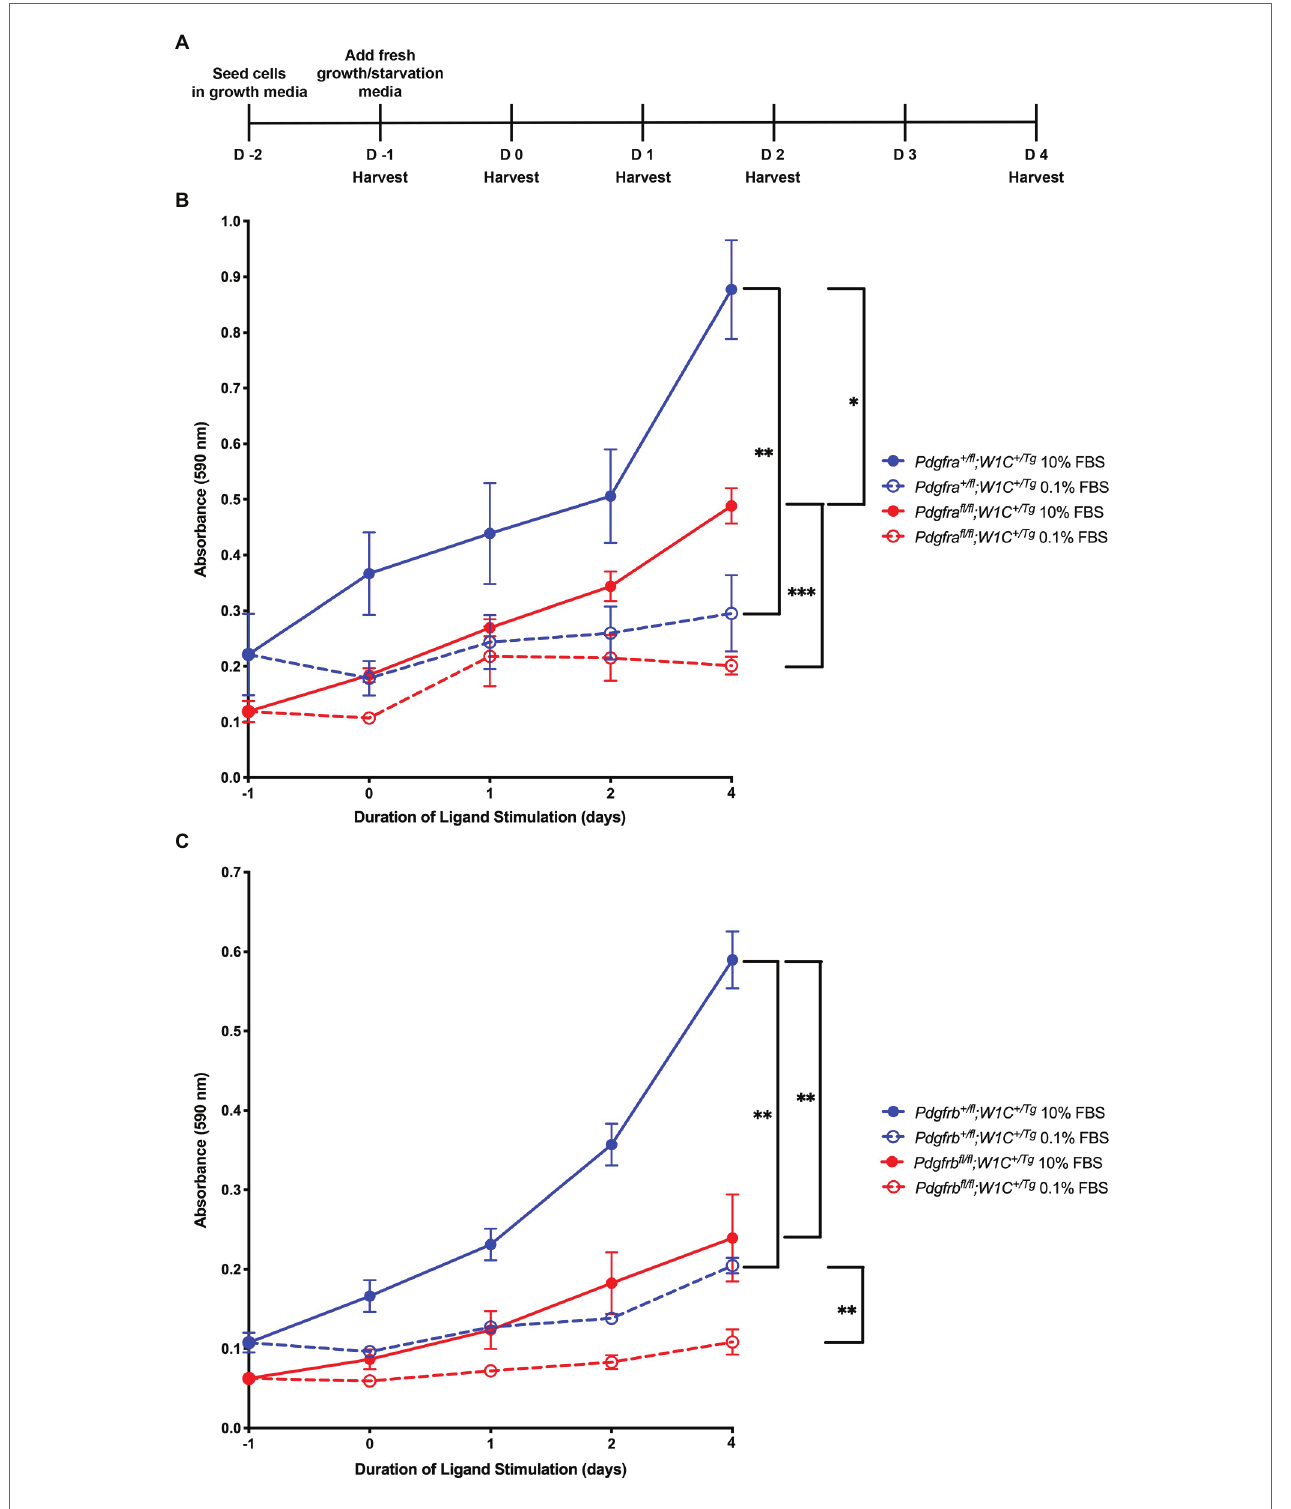
FIGURE 10 | PDGFR β plays a more dominant role in proliferation of primary MEPM cells than PDGFR α . (A) Experimental design for cell growth assays. (B) Line graph depicting absorbance values at 590 nm in Pdgfra +/fl ; Wnt1-Cre +/Tg vs. Pdgfra fl/fl ; Wnt1-Cre +/Tg primary MEPM cells across conditions. Data are presented as mean ± SEM. * p < 0.05; ** p < 0.01; *** p < 0.001. (C) Line graph depicting absorbance values at 590 nm in Pdgfrb +/fl ; Wnt1-Cre +/Tg vs. Pdgfrb fl/fl ; Wnt1-Cre +/Tg primary MEPM cells across conditions. Data are presented as mean ± SEM. ** p <